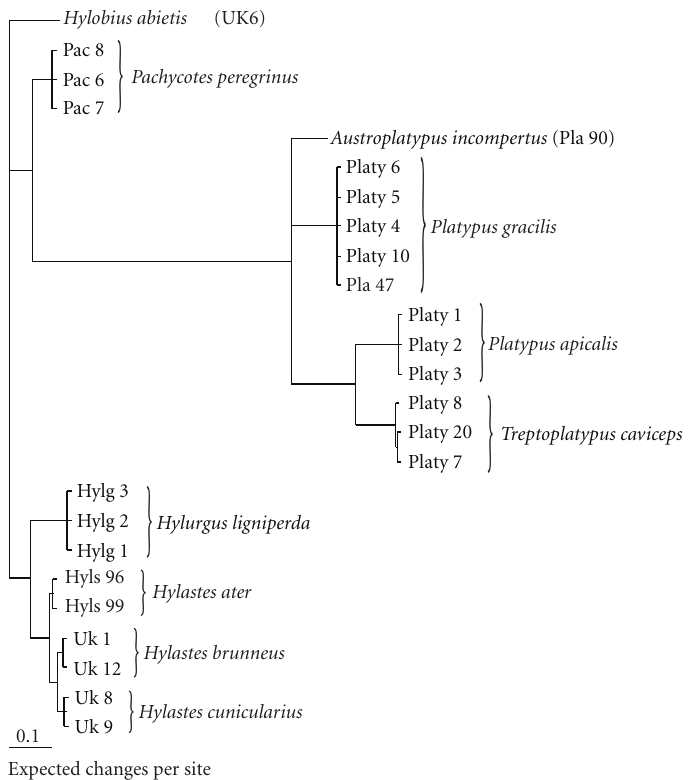
Figure 1: Representation of the species divergence using comparison of partial 28S rDNA